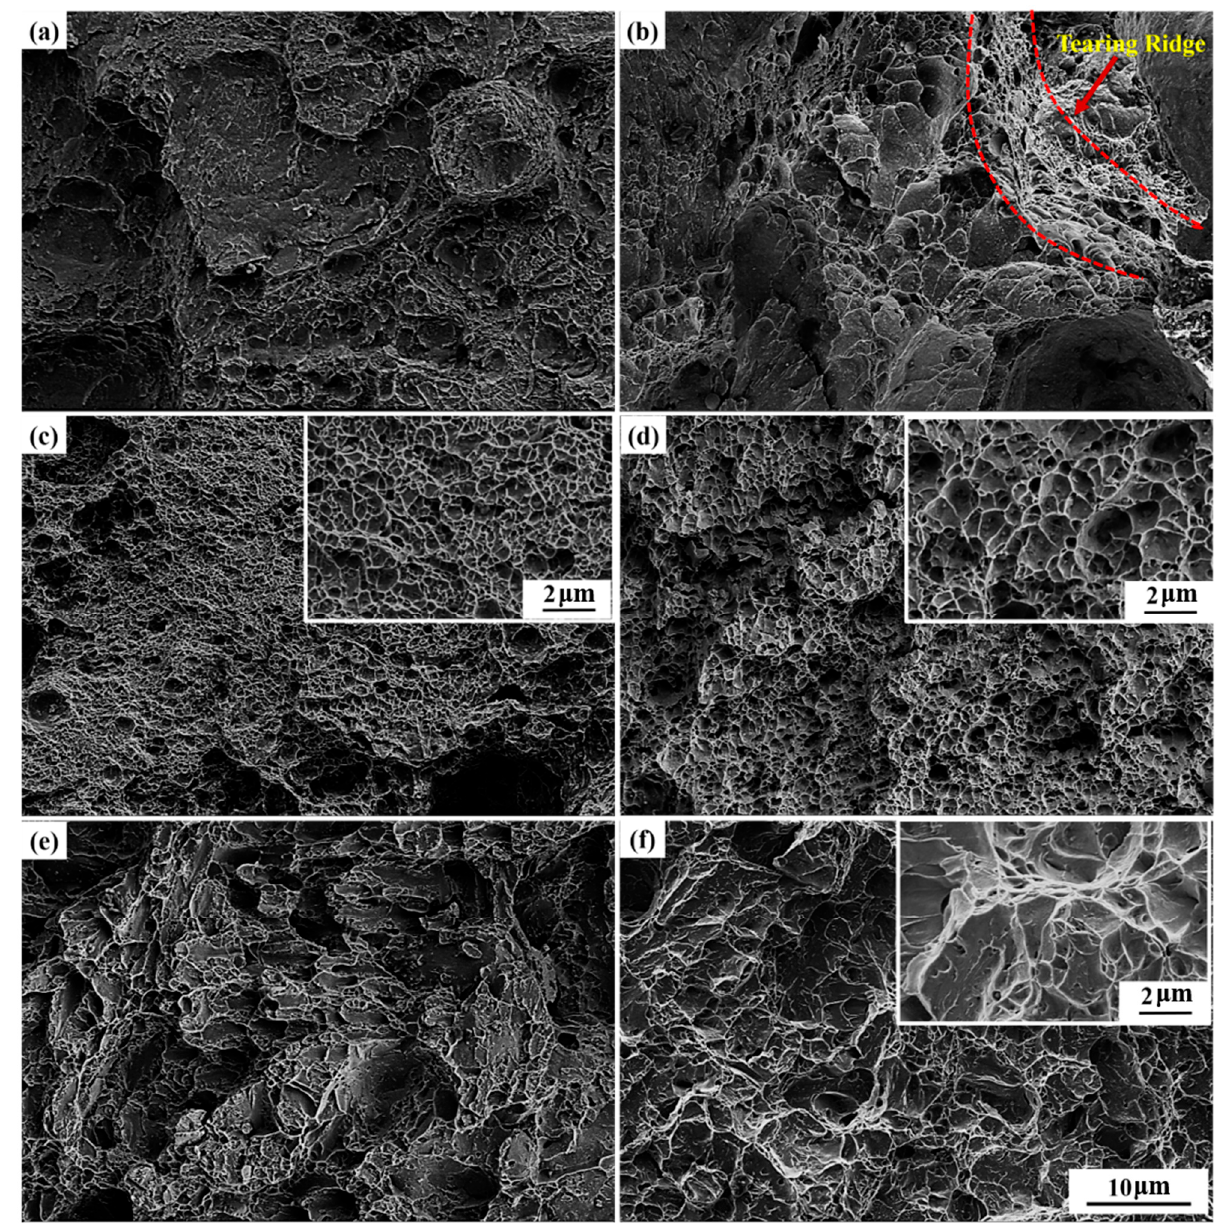
Figure 9. High-magni fi cation SEM images of fracture morphology of 35CrMo steel tempered at different temperatures: ( a ) 580 °C, ( b ) 610 °C, ( c ) 640 °C, ( d ) 680 °C, ( e ) 710 °C, and ( d ) 740 °C.